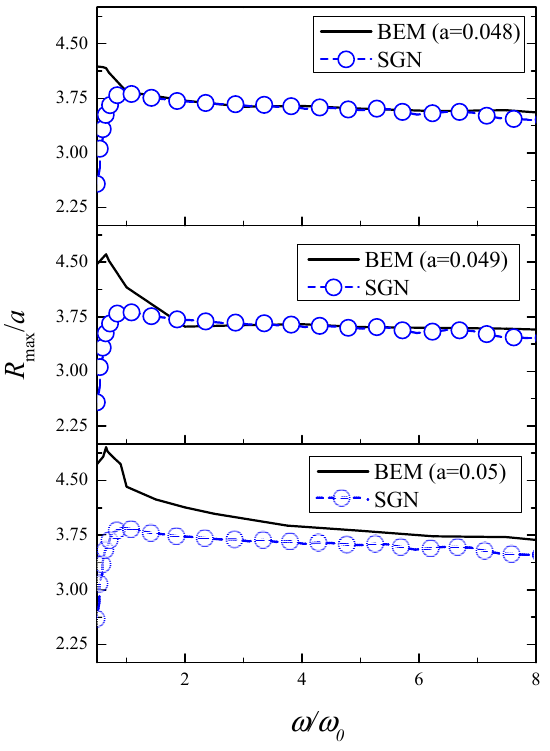
Figure 7. MWR along the vertical seawall for double-crest wave train cases.